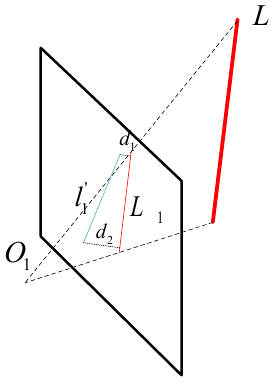
Figure 5. Reprojection error of line features.